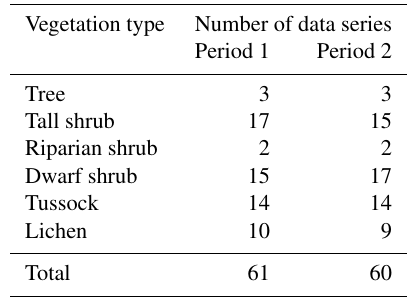
Table 1. Number of data series per vegetation type in each mea- surement period; period 1: 27 August 2016, 17:00 (local time) to